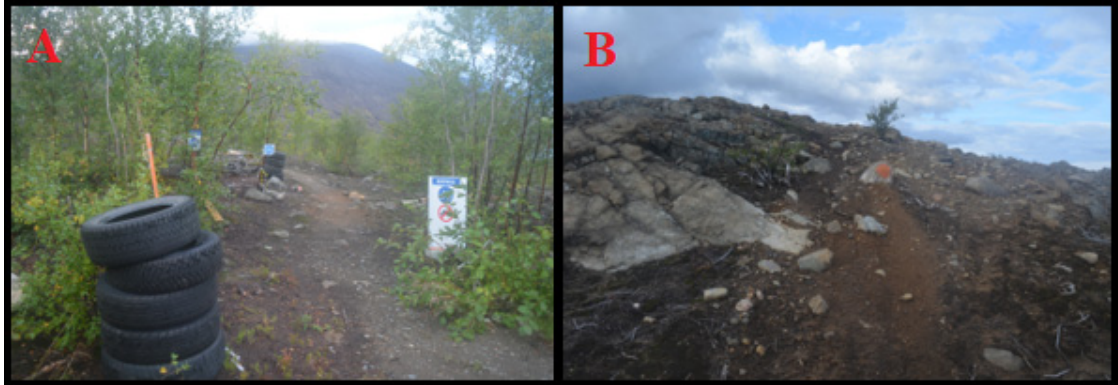
Figure 8. Examples of field trail delineation by residents’ initiative: bike trail marked with used tires ( A ) and paint-painted markings on rocks ( B ).